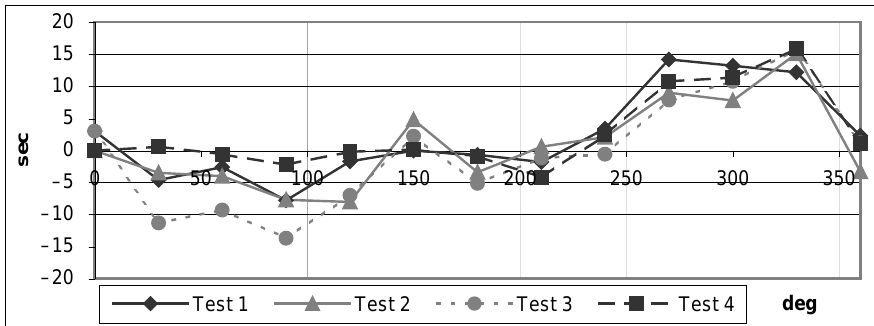
Fig 4. Graphs of the tacheometer readings errors (20 02 2006)